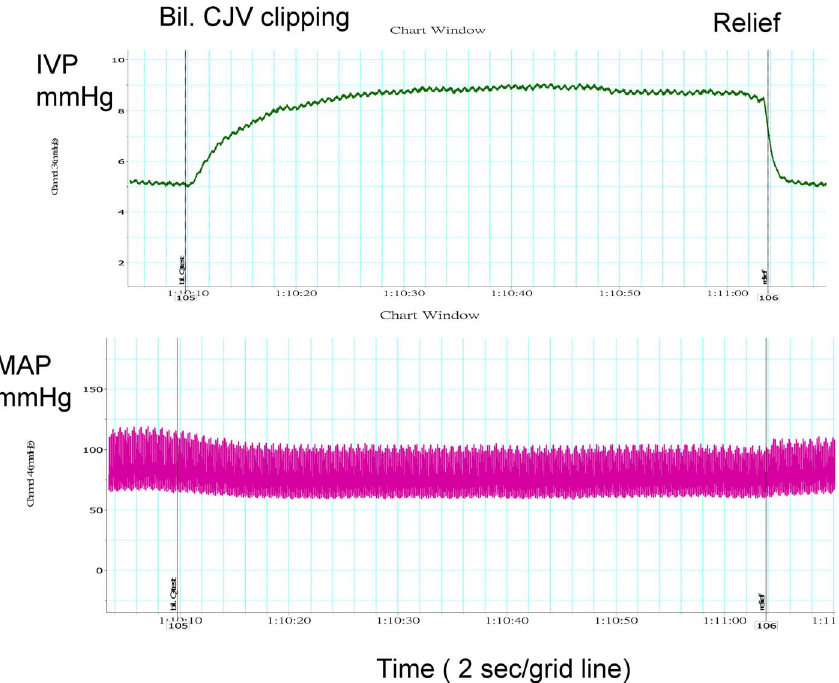
Figure 2. Changes in the intraventricular pressure (IVP) and mean arterial pressure (MAP) of SD rats due to bilateral common jugular venous (Bil. CJV) clipping.